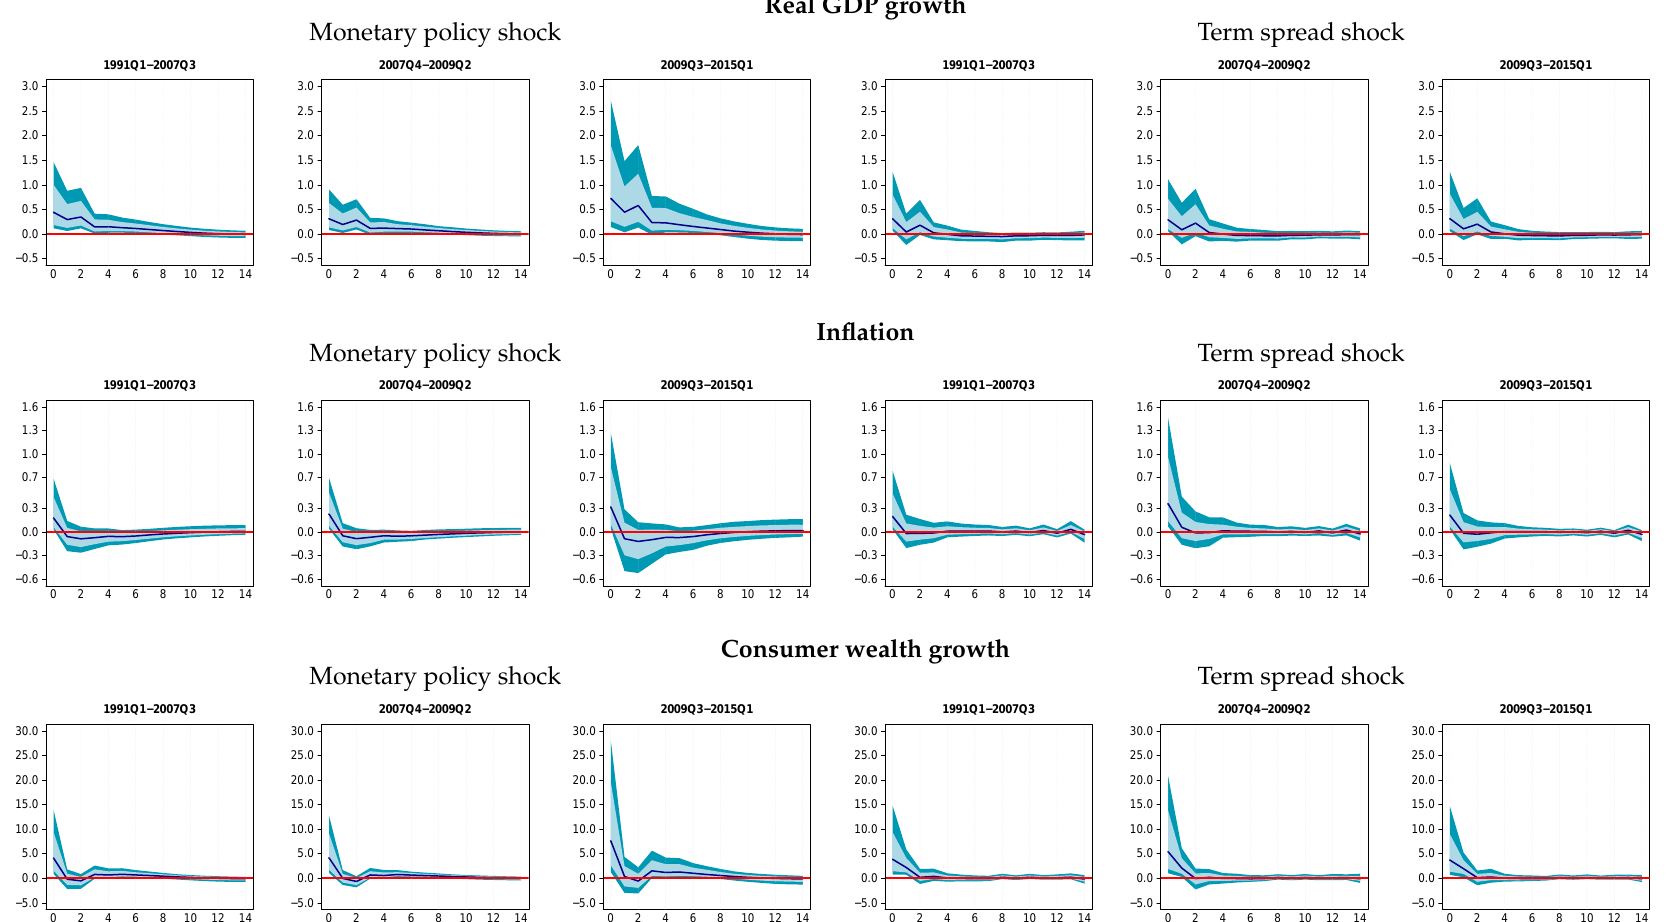
100 bp) and shock to the term spread ( 100 bp) − −